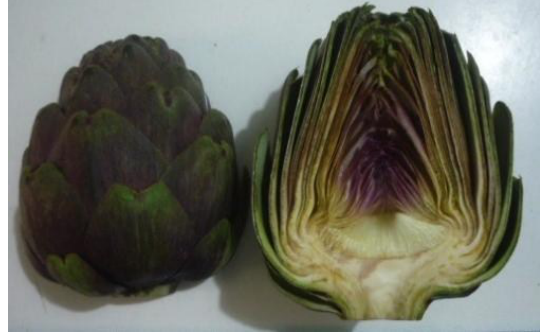
Figure 2. A typical flower head of the “Lucera artichoke”.